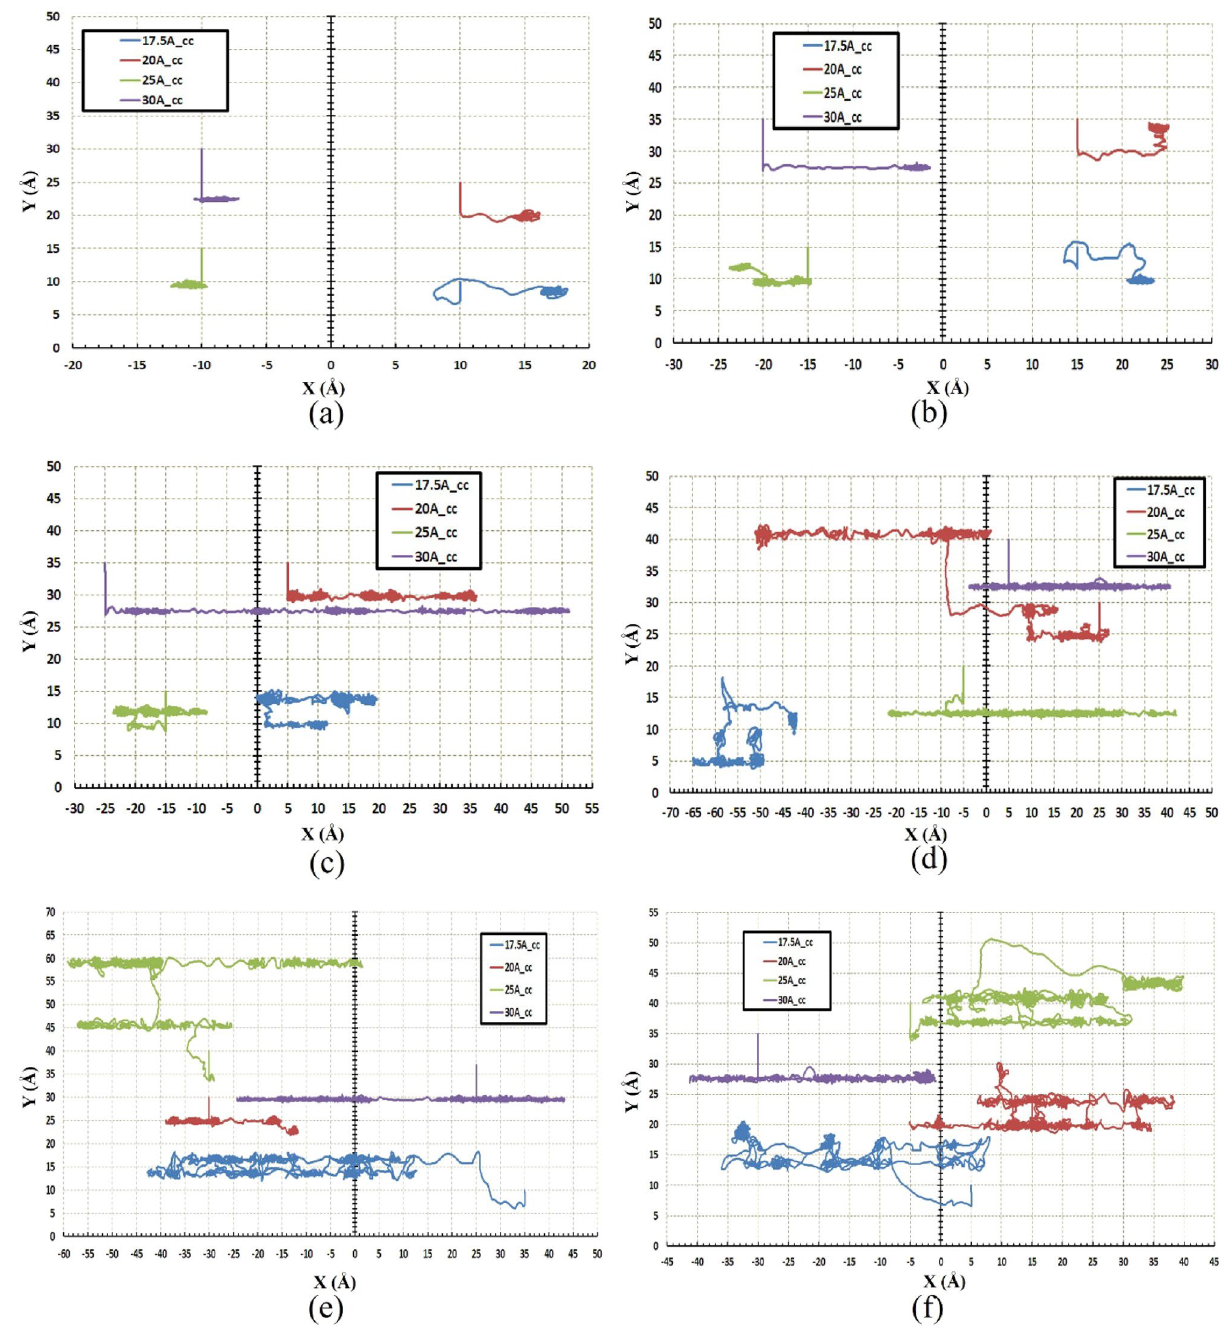
Figure 5. Trajectories of the C 60 on the concave (cc) gold substrates during simulations ( a ) 75 K , ( b ) 150 K , ( c ) 300 K , ( d ) 400 K , ( e ) 500 K , and ( f ) 600 K . The initial deviation of the molecule at the beginning of the movement was because of adsorption towards the edges (due to the high surface-to-volume